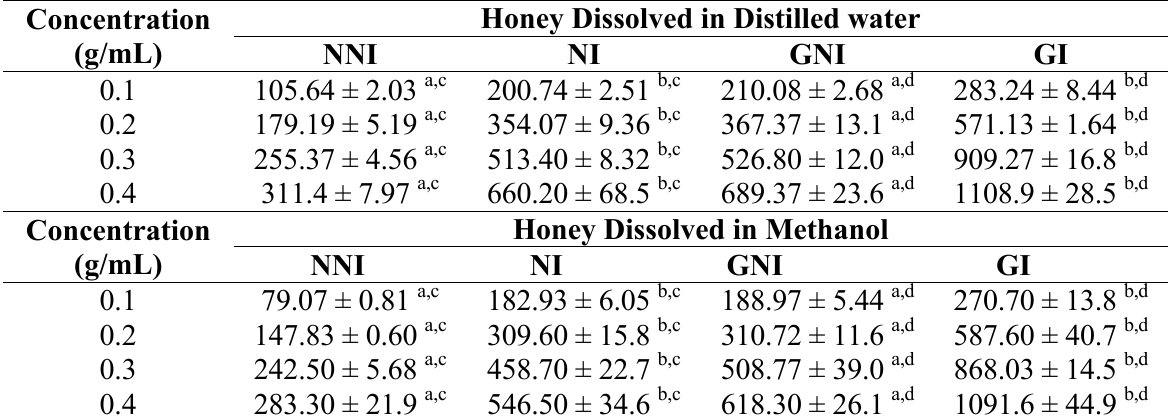
Table 1. Ferric Reducing Antioxidant Power (FRAP) values of Gelam and Nenas honeys before and after